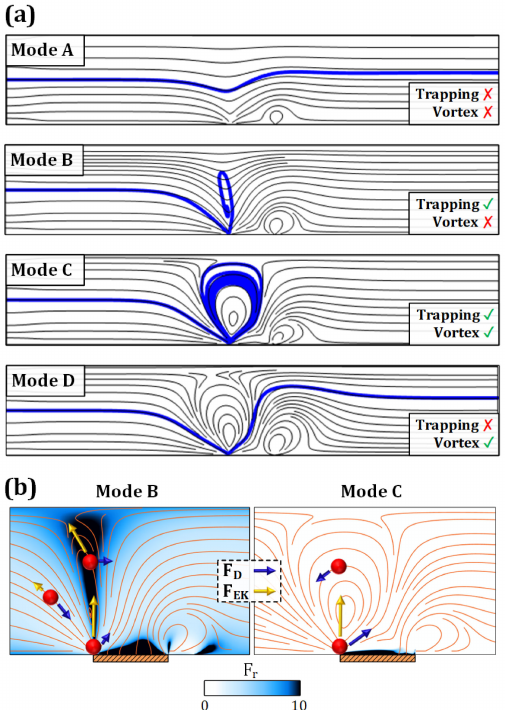
Figure 7. Particle trapping/escaping modes. ( a ) Different particle modes occurrence mainly because of particle EP (fluid streamlines are shown). Mode A (Allowed): no vortex and no trapping, Mode B (Blocked): no vortex but trapping, Mode C (Captured): fluid vortex and trapping, and Mode D (Dodged): escaping from the vortex. The last two modes are desirable for multi-particle separation, where both particle size and charge are decisive. ( b ) Diagram of forces acting on negatively charged particles at different locations during modes B and C (the streamlines are for particle velocity and not fluid velocity). As particles advance toward the membrane, the F EK rises due to the high electric field and its gradient. In mode B, EK force slows down the particle before reaching the membrane, and together with the drag force, induces a spiral-like motion to particles even without the existence of a vortex. This only happens for a particular condition where EP dominates the drag force at the high electric field area. It should be mentioned that DEP is only significant within a small bandwidth (1 [ µ m]) above the membrane. For instance, in mode C, the particle is captured by its size and DEP